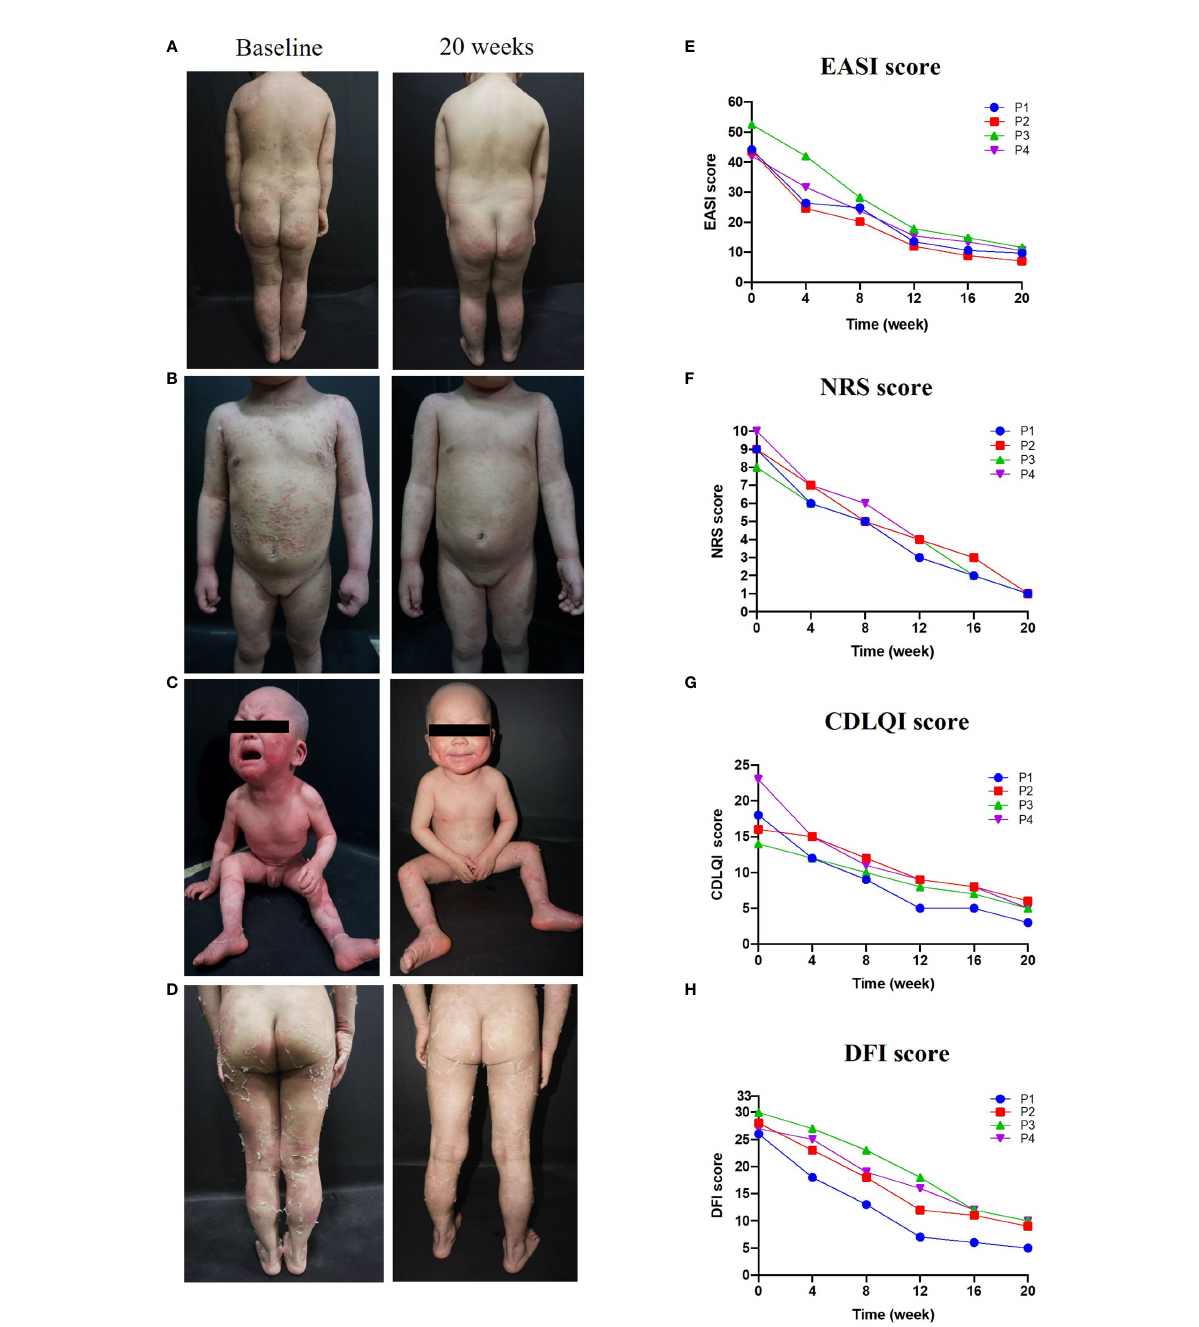
FIGURE 1 Improvements in clinical symptoms and QoL after 20 weeks of dupilumab treatment Images in (A – C) , and (D) show clinical pictures of patients 1,2,3, and 4 before and 20 weeks after treatment with dupilumab, respectively. (E – H) displayed changes in disease severity, pruritus, and QoL over time of treatment, (E) Eczema Area and Severity Index (EASI), (F) the Numerical Rating Scale (NRS), (G) the Dermatology Life Quality Index (CDLQI), and (H) the Dermatitis Family Impact-questionnaire